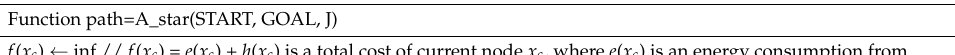
Algorithm 1: The improved A* algorithm pseudocode